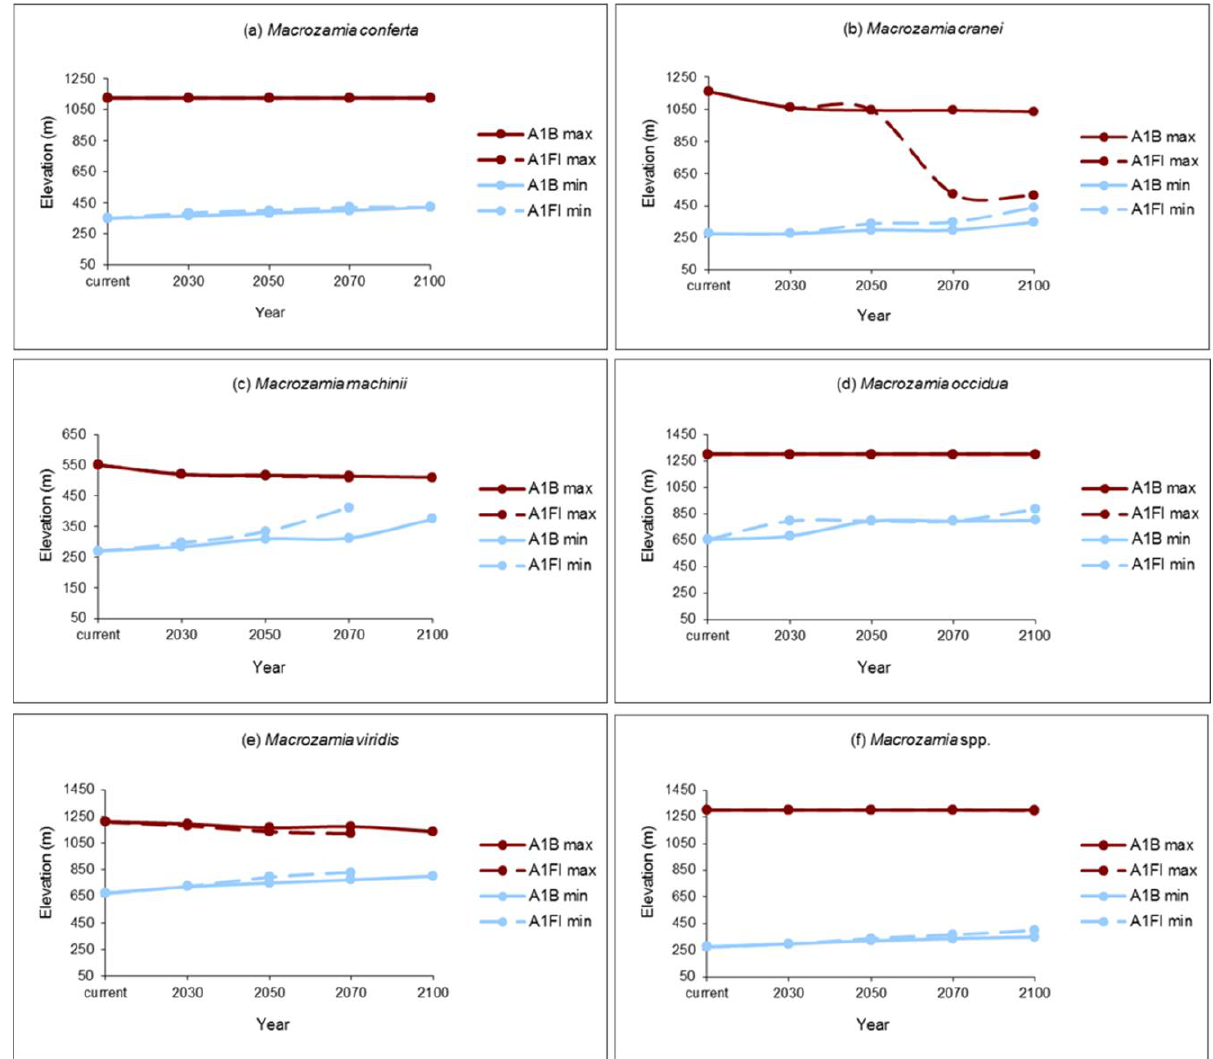
Figure 4. Maximum (max) and minimum (min) elevations of potential habitat ranges modelled for Darling Downs Macrozamia cycads with increasing annual mean temperature under A1B and A1FI emission scenarios (a) M. conferta , (b) M. cranei , (c) M. machinii